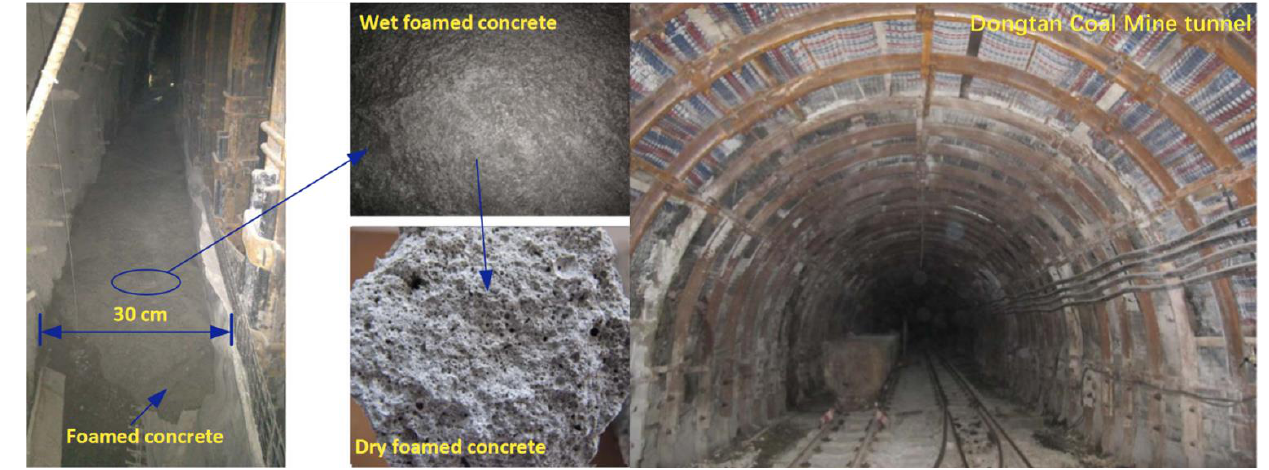
Figure 21. Applications of foamed concrete in the Duntan Tunnel [128].